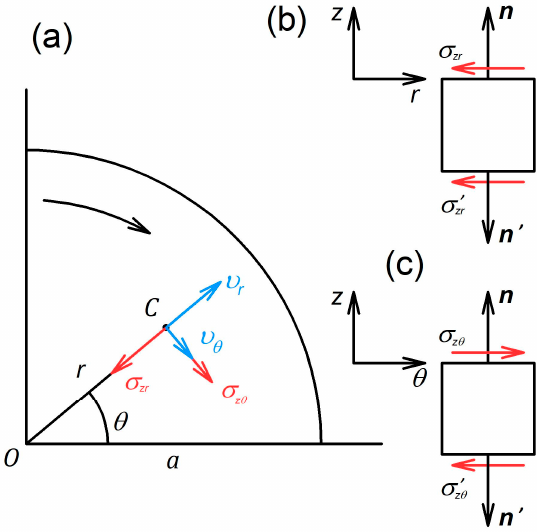
Figure 1. Schematics explaining the directions of the shear stresses on the contact surfaces between the specimen and the anvils: ( a ) upper surface normal to the anvil rotation axis, ( b , c ) cross-sections of the specimen perpendicular to the θ - and r -axes, respectively. The rotation of the upper anvil is indicated by the curved arrow. The notation in the figure is as follows: v r and v θ are the components of the velocity vector at point C ; n and n (cid:48) are the vectors normal to the upper and lower surfaces of the specimen, respectively. All other symbols are defined in the text.